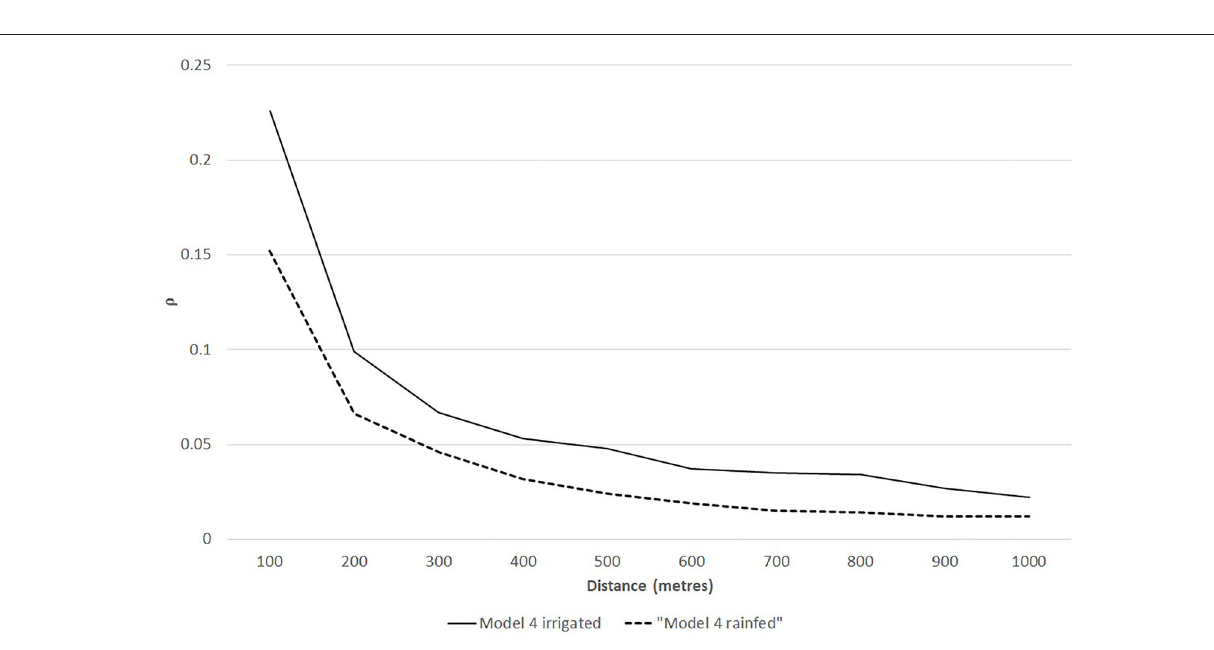
Frontiers in Sustainable Food Systems |